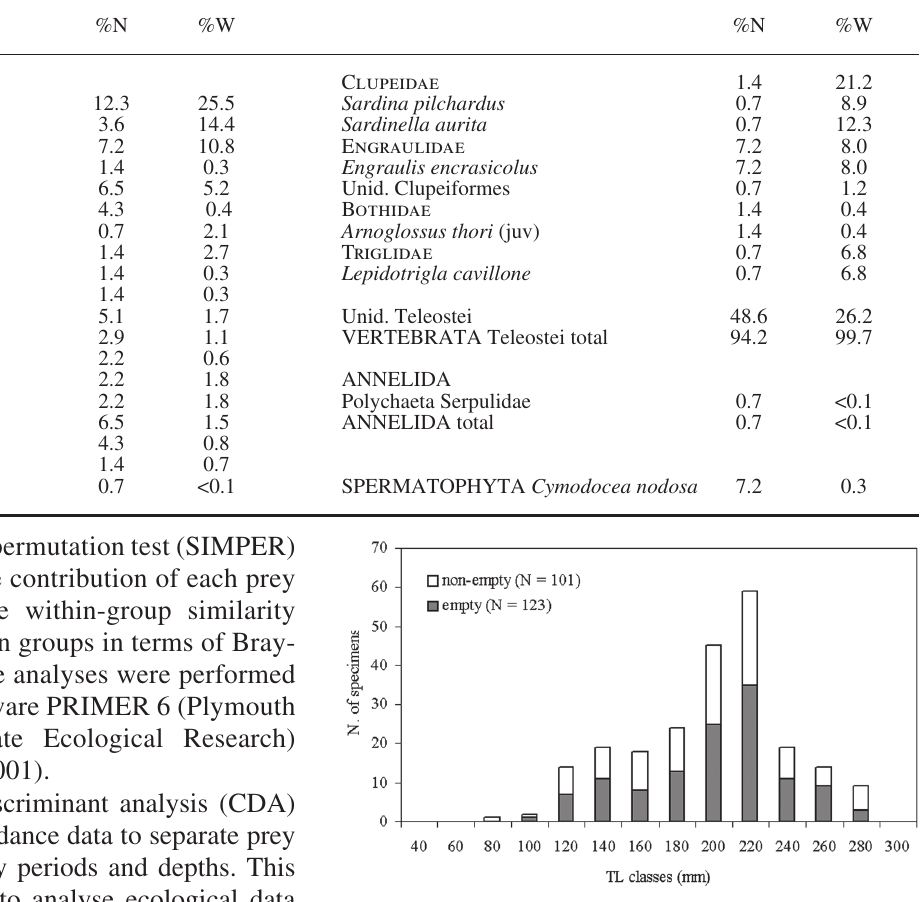
Fig . 2. – length frequency distribution of specimens of S. saurus with empty and non-empty